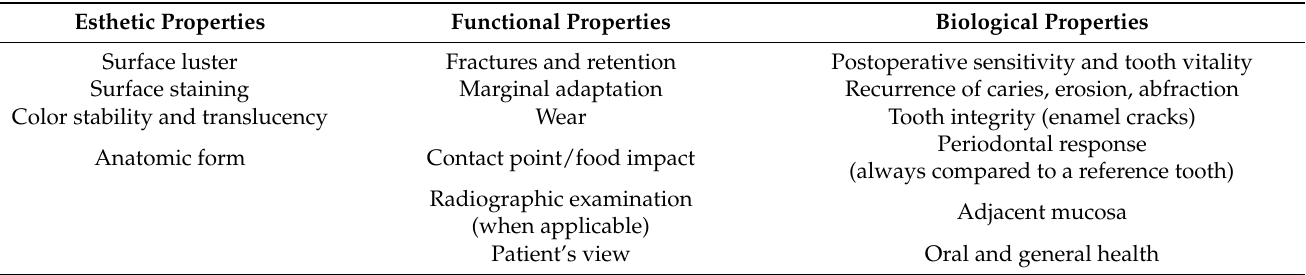
Table 1. World dental federation (FDI) criteria for evaluation of indirect restorations.